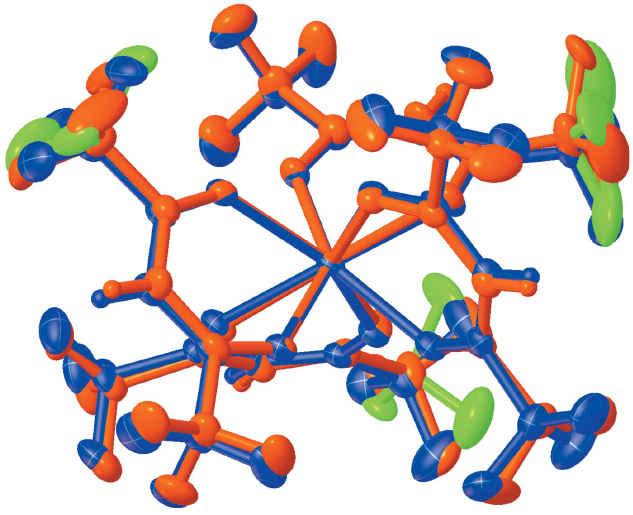
Figure 2 Overlay of the crystallographically inequivalent Hf(hfac) 4 molecules with molecule 1 in orange, molecule 2 in blue, and the disordered CF 3 groups in green; r.m.s. deviation = 0.004 A˚